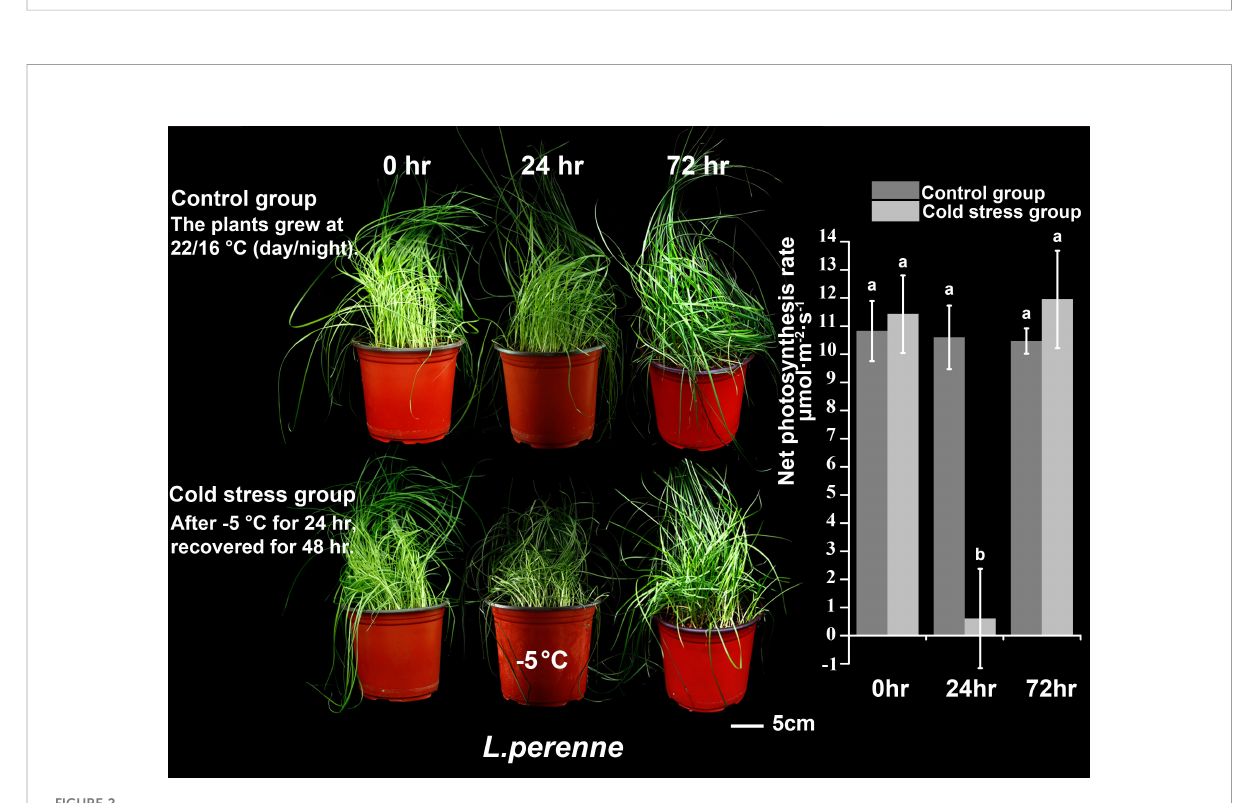
FIGURE 1 The cold stress ( − 5°C) and recovery of P. crymophila